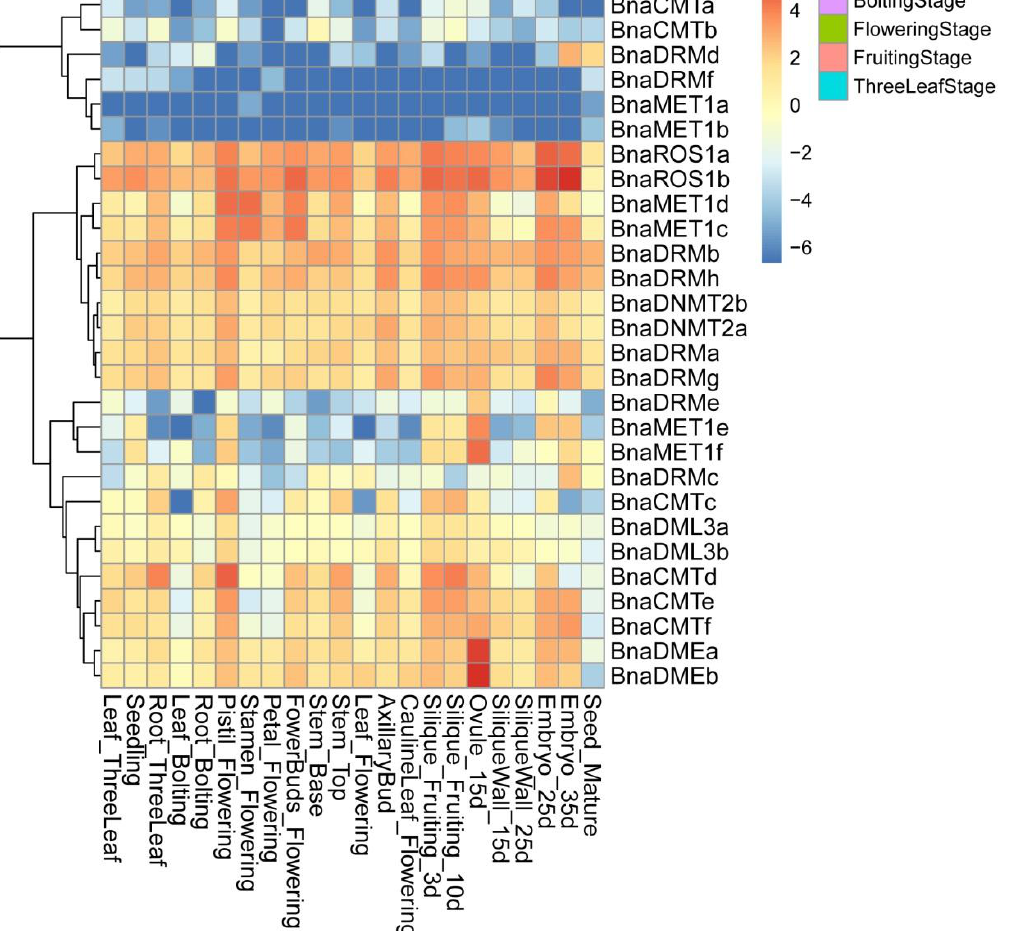
Figure 5. DNA methylation levels and gene expression patterns of 30 DAF endosperm in 93275